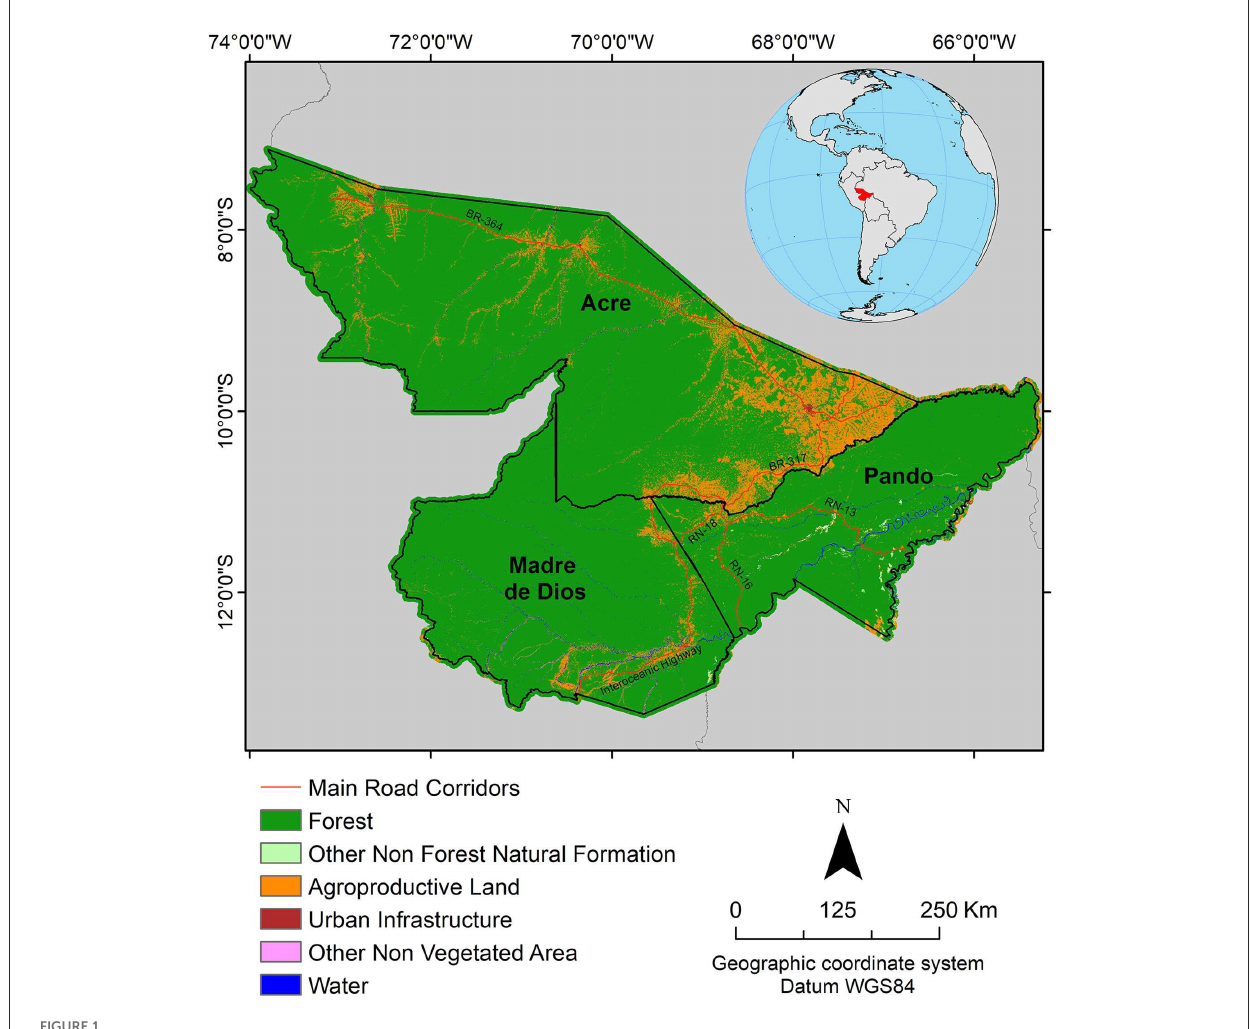
FIGURE1 Geographic location of the study area.